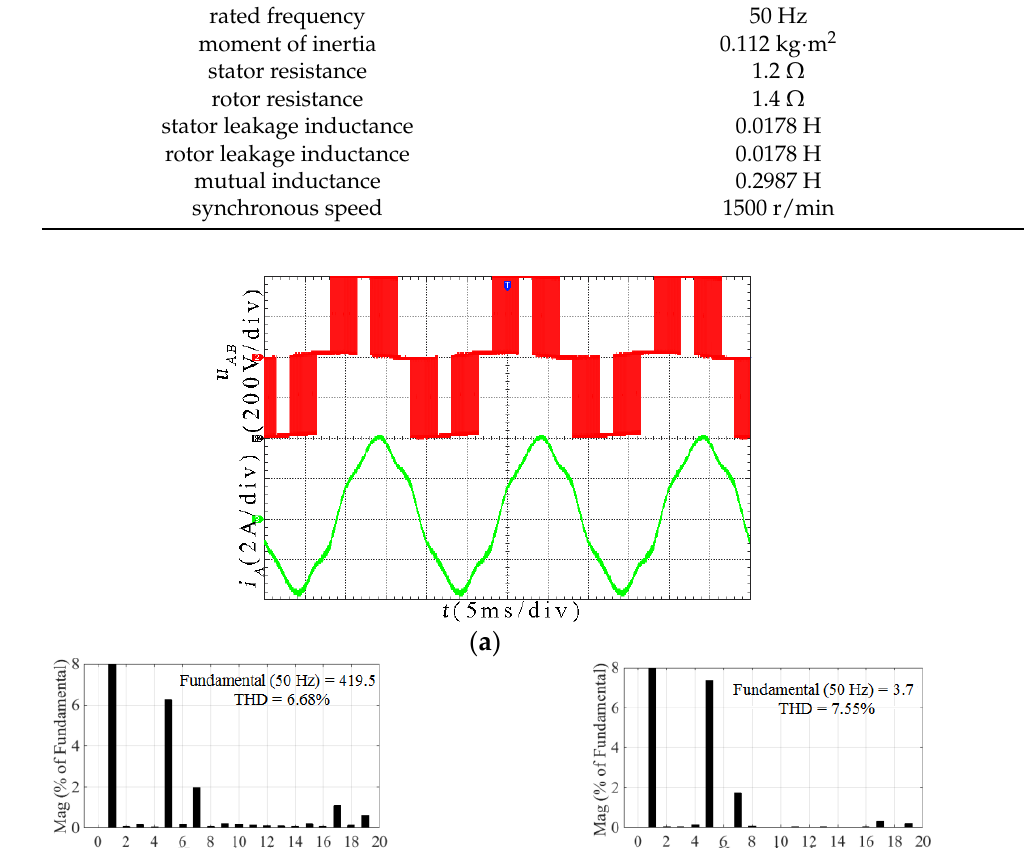
Figure 12. The experiment platform. Table 4. Parameters of the experimental six-phase motor.